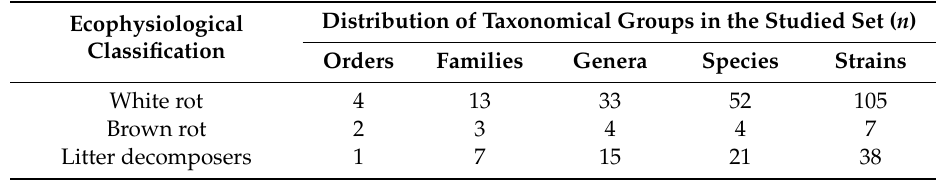
Table 3. Overview of the ecophysiological and taxonomical classification of the studied Basidiomycetes.